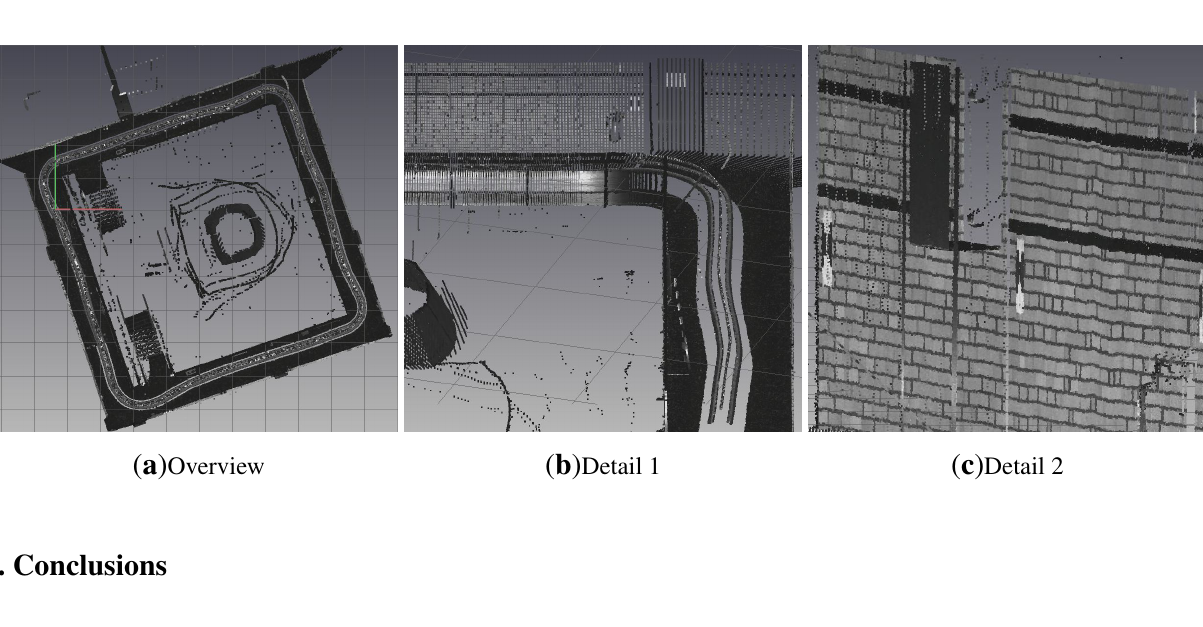
Figure 13. Images ( a – c ) show a point cloud measured with IMU, scanner and total station. (a) Overview of trajectory 1, as in Figure 8a; (b,c) show that a generally good point cloud could be created; ( c ) shows some